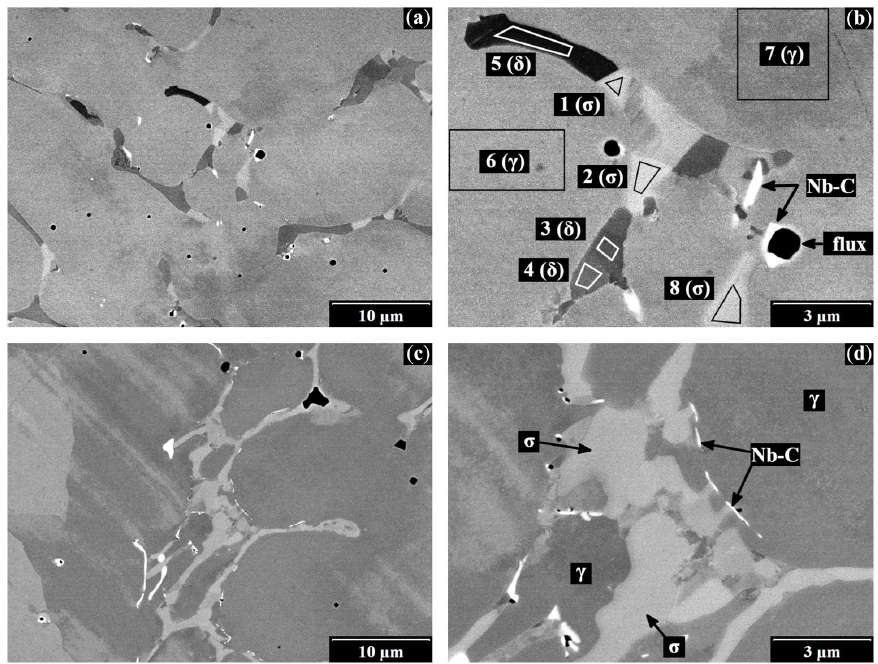
Figure 4. Typical solidification aggregates in the area of crack propagation in the T4 specimen ( a , b ), a dendritic zone, DENZ, and in the T5 specimen ( c , d ), transition zone, TRZ. The former was charac- terized by sparsely distributed aggregates having relatively small dimensions, while the latter was characterized by large thick continuous aggregates, and the complete transformation of delta-ferrite into the sigma phase. The images were collected using the backscattered electron COMPO detection mode of SEM. EDX analysis was performed in sites 1–8 of the area in figure ( b ); corresponding data are listed in Table 2.